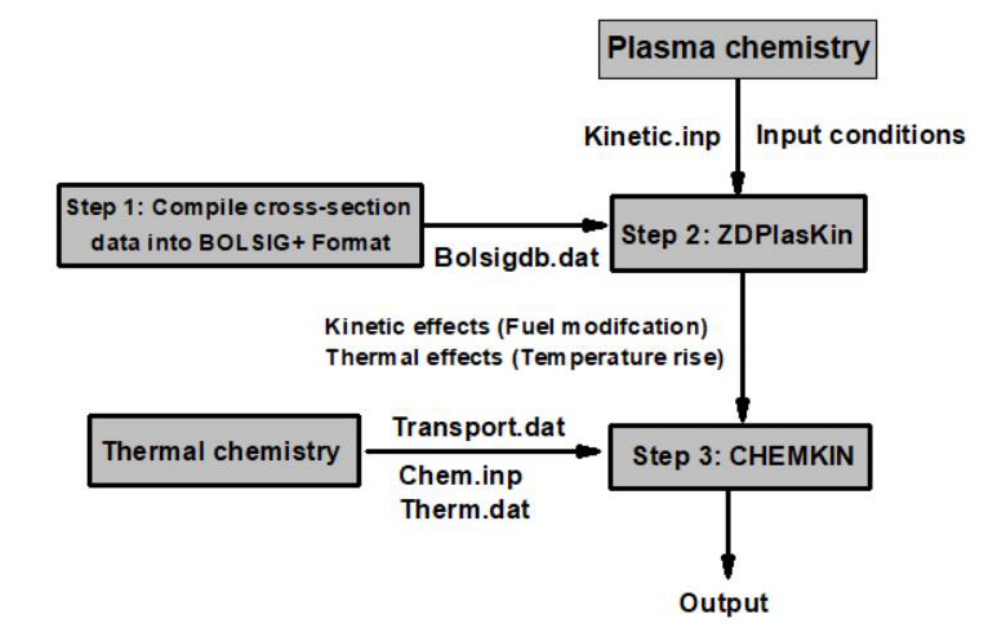
Figure 1. Flowchart for numerical analysis.